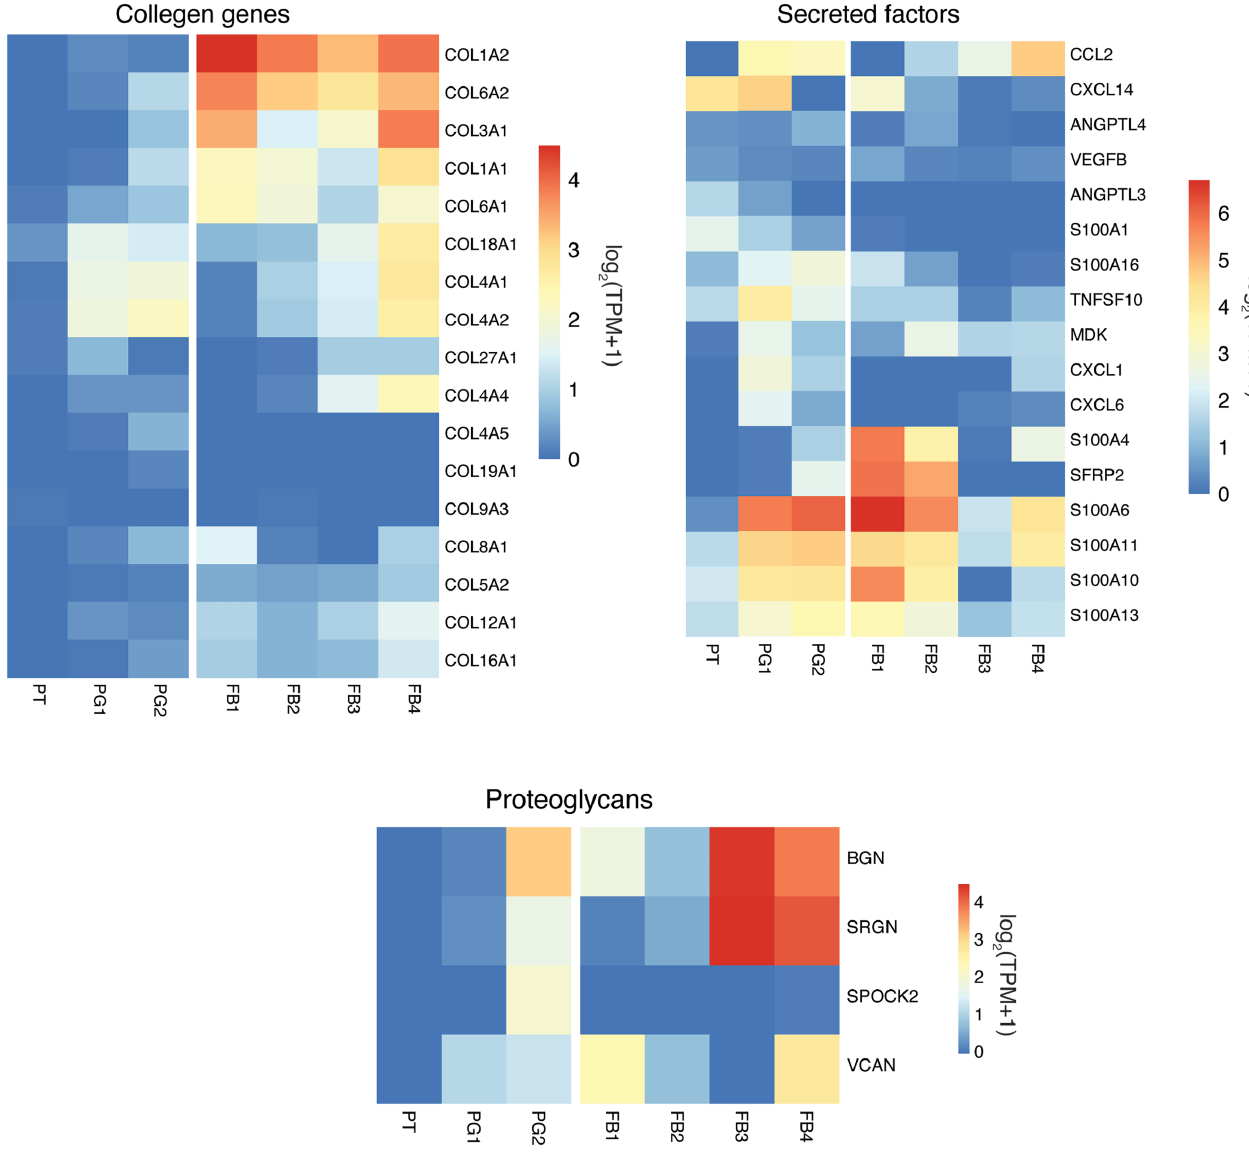
Fig 11. Top expressed genes of matrisome groups in fibroblasts, proximal tubular, and tubular progenitor cells. Figure depicts heatmap of the top expressed matrisome genes in the proximal tubular cells, tubular progenitor cells, and fibroblasts.